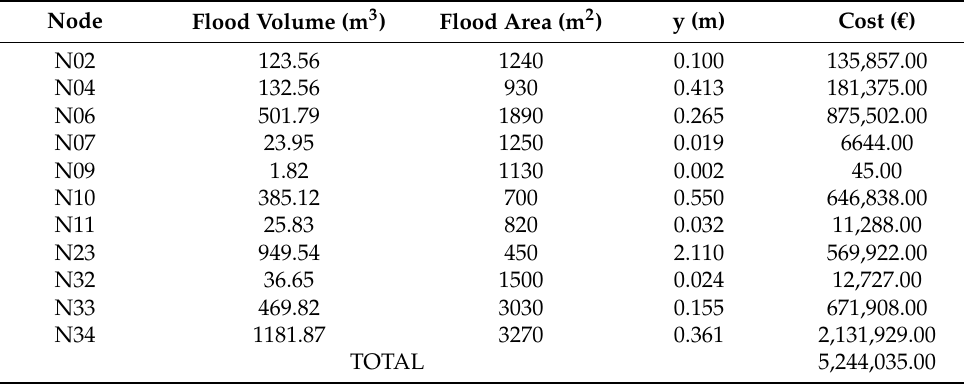
Table 1. Flood on nodes and cost of damage in the current state of the